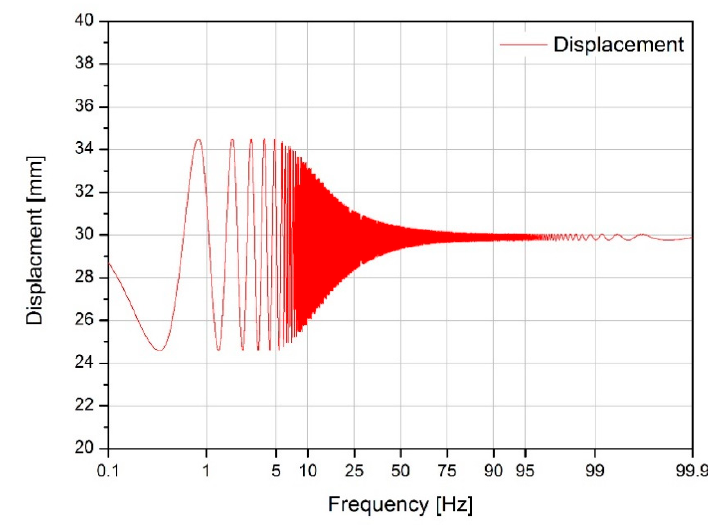
Figure 15. Displacement test results of hydraulic servo actuator according to the frequency change of the power control device.